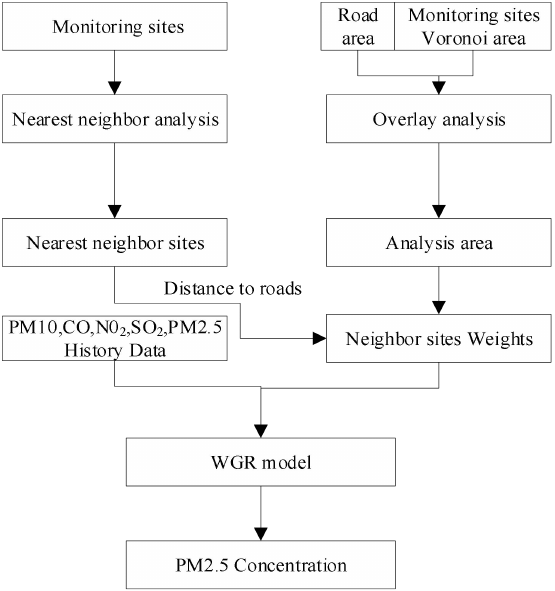
Figure 3. PM2.5 Spatiotemporal Prediction flow